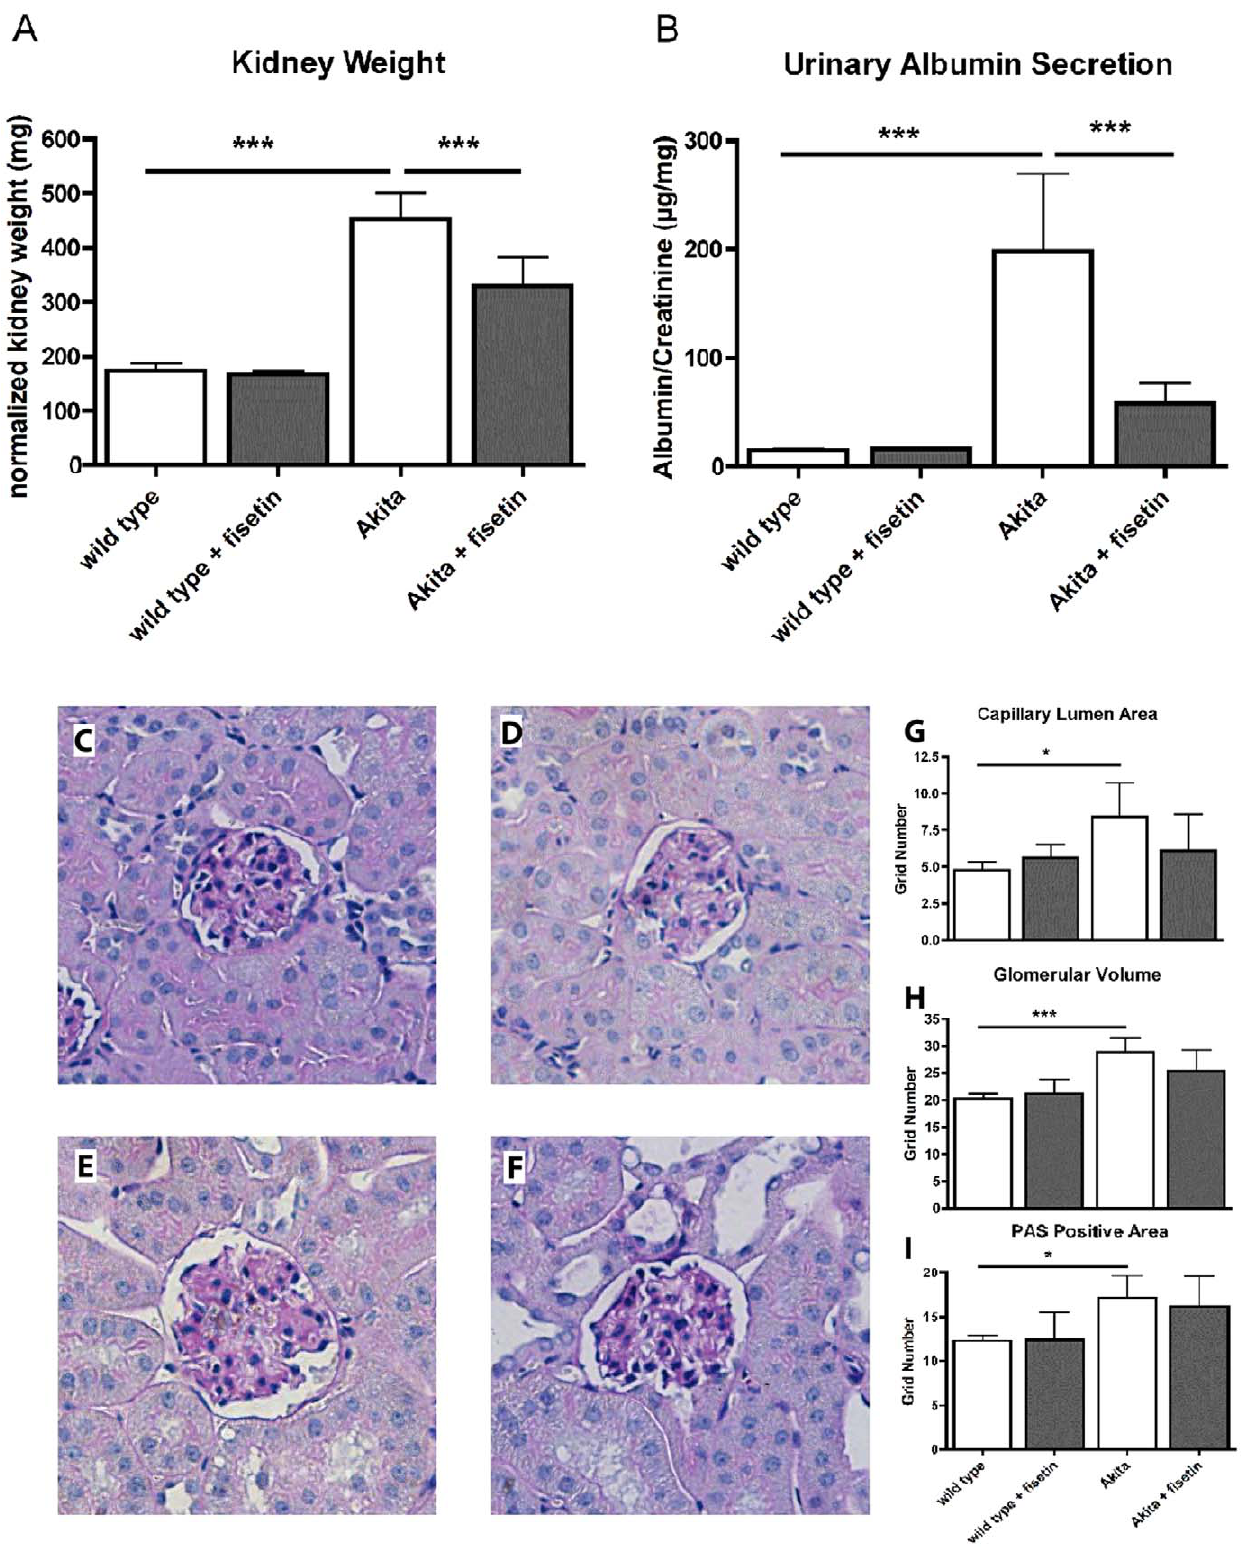
Figure 1. Fisetin reduces the consequences of diabetes in Akita mice. Male Akita mice were fed control diet or fisetin (0.05%) for 18 weeks beginning at 6 weeks of age. (A) Kidney hypertrophy was assessed by weighing the kidneys and normalizing the kidney weight to the relative weight of the mice. (B) Kidney function was assessed by measuring the albumin/creatinine ratio in the urine. Fisetin reduced diabetes-induced renal hypertrophy and albuminuria. Capillary lumen area, glomerular volume and PAS positive mesangial matrix area were increased in Akita mouse kidneys (E, F: + fisetin) compared with wild type mice (C, D: + fisetin). The increase in capillary lumen area (G) ( p , 0.05) and glomerular volume in the